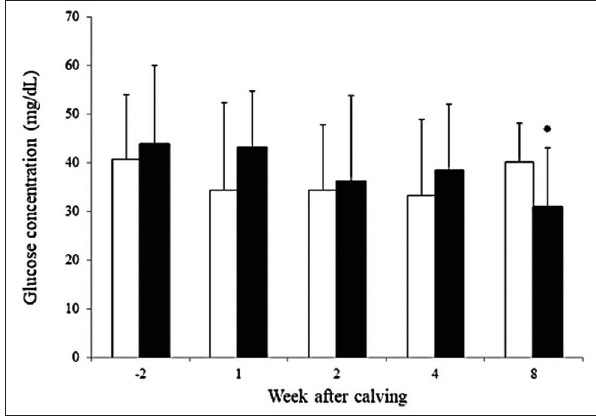
Figure-1: Farm average milk productions in smallholder (broken line, n=3) and semi-commercial (solid line, n=2) during experimental period, error bars stand for standard deviation.